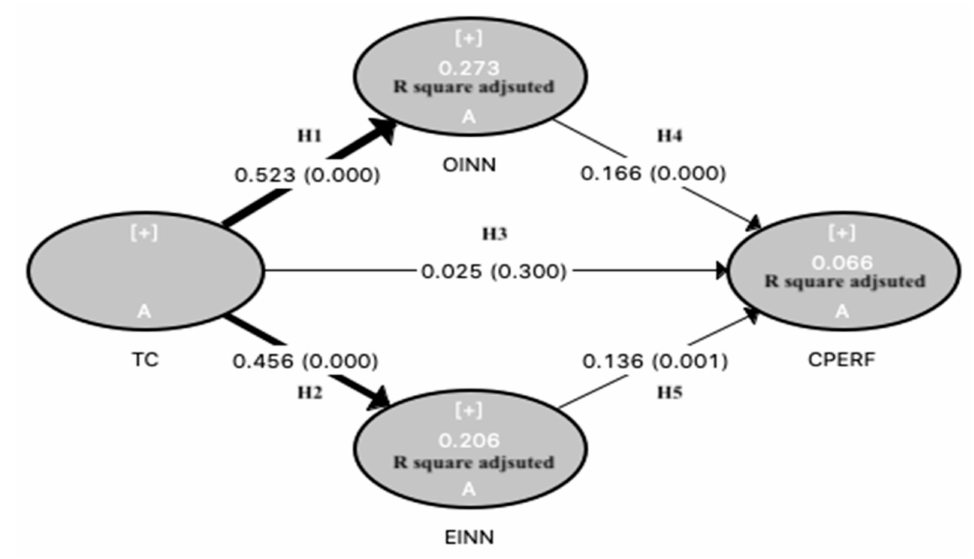
Figure 2. Nomogram of the study (structural model).